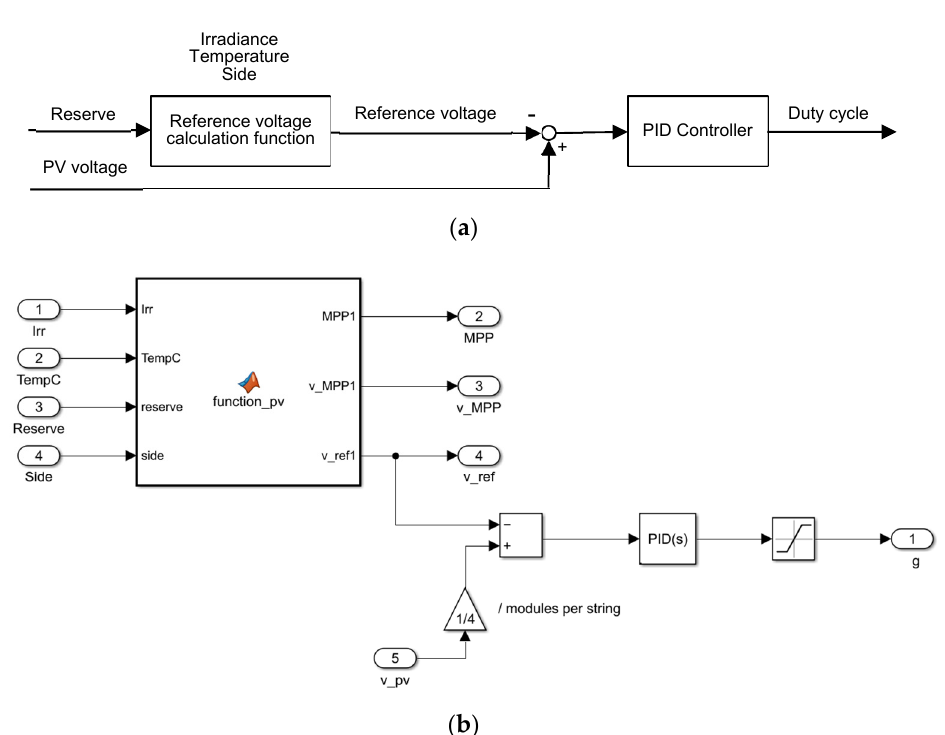
Figure 6. Voltage control subsystem: ( a ) General flowchart; ( b ) Simulink implementation.